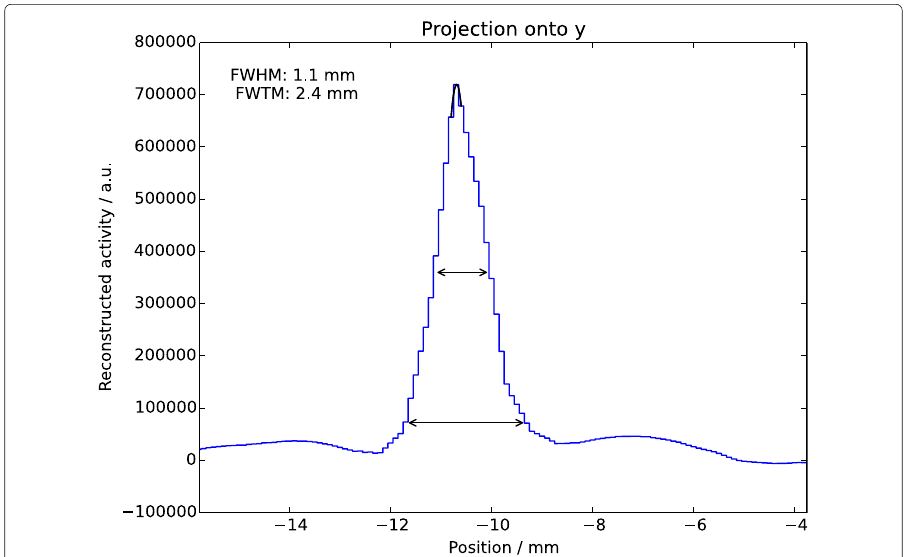
Fig. 3 Line profile of the reconstructed point source projected onto the y axis. The star-like artifact which is aligned with the x axis creates an excess in activity at the peak of the profile boosting the spatial